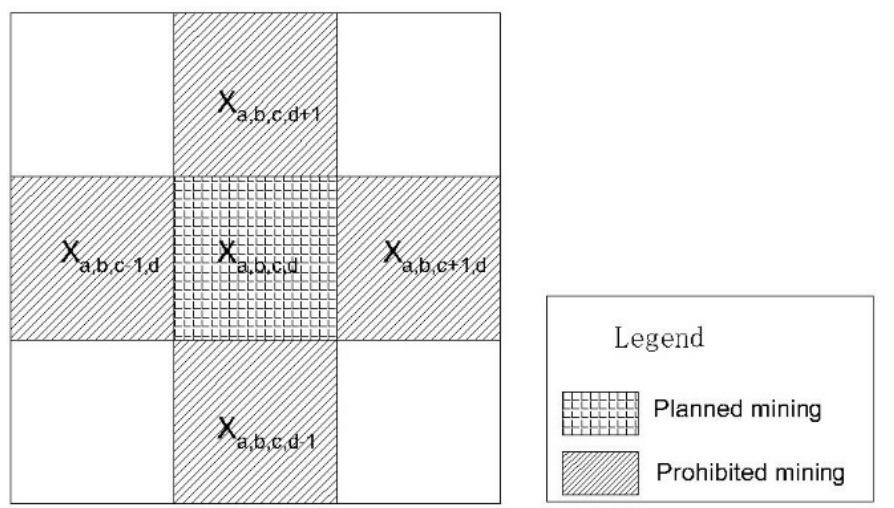
Figure 3. Horizontal direction mining rule.